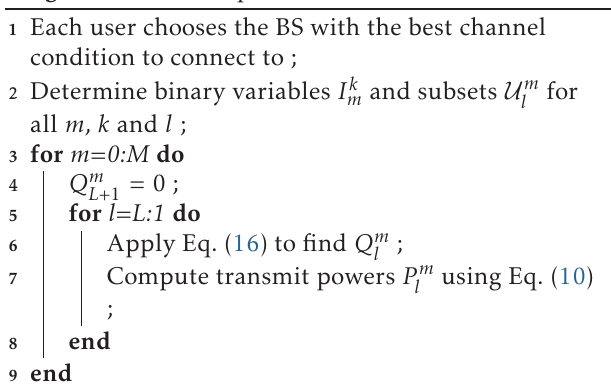
Algorithm 1: A Simple Heuristic